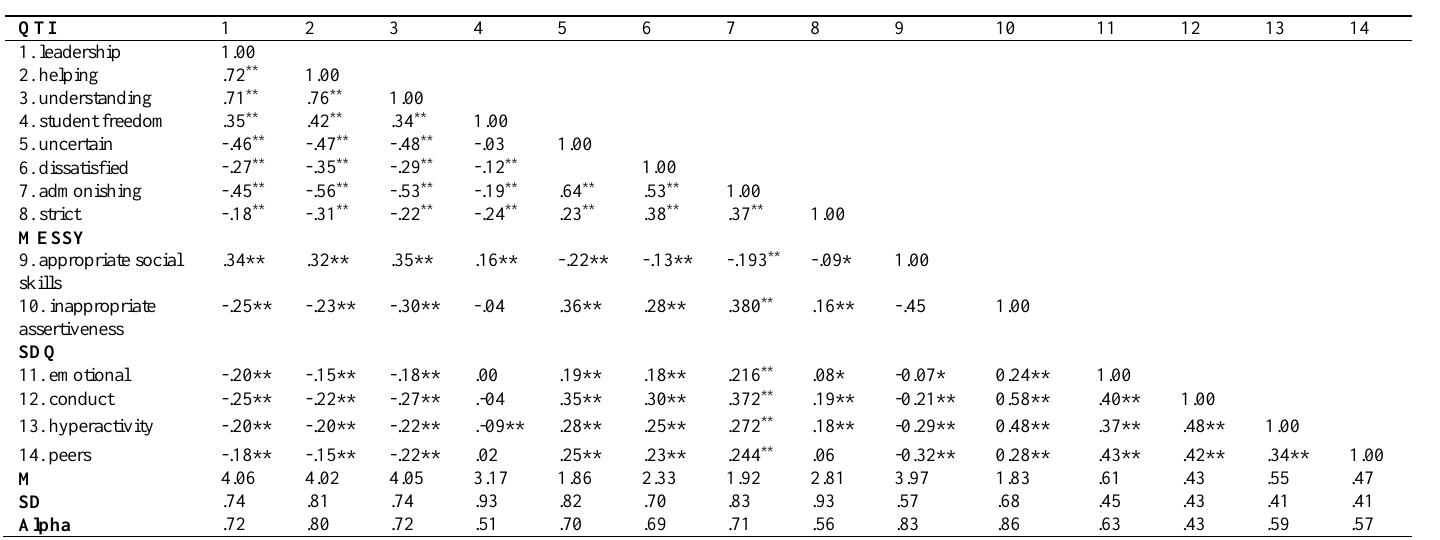
Correlation coefficients for the